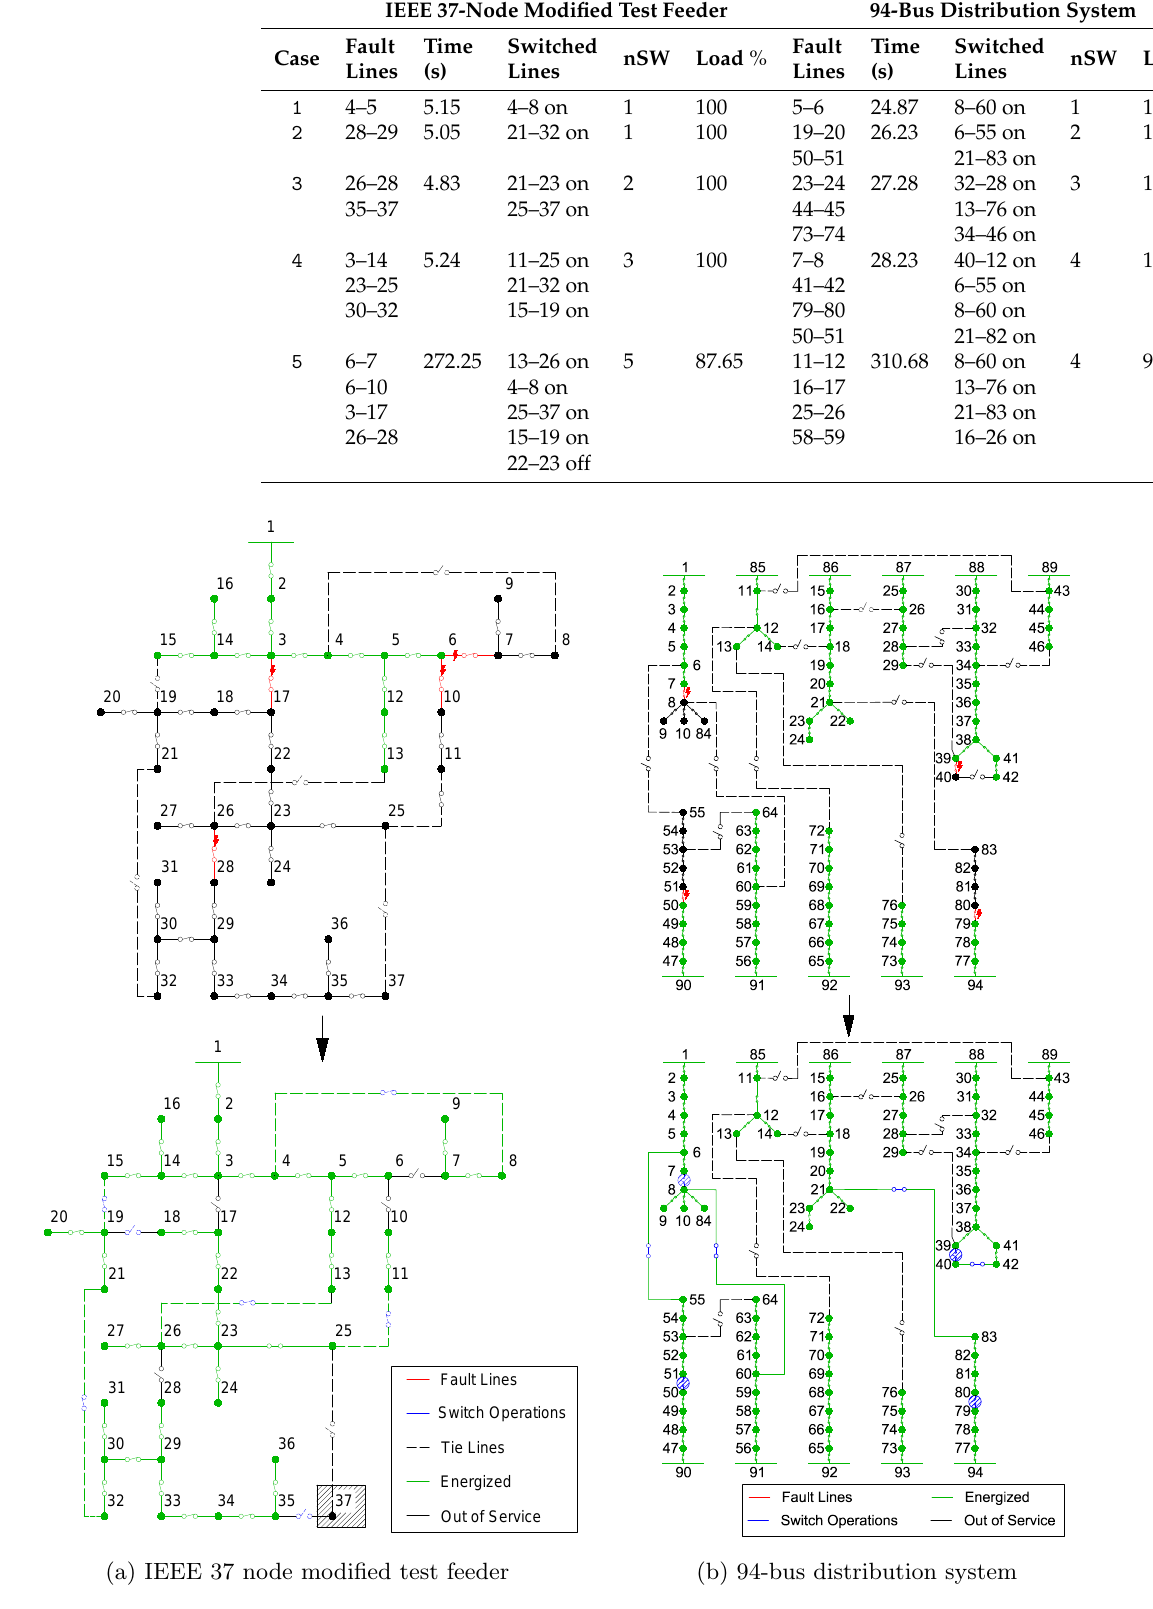
Figure 8. Reconfiguration of IEEE 37 modified test feeder and 94-bus distribution